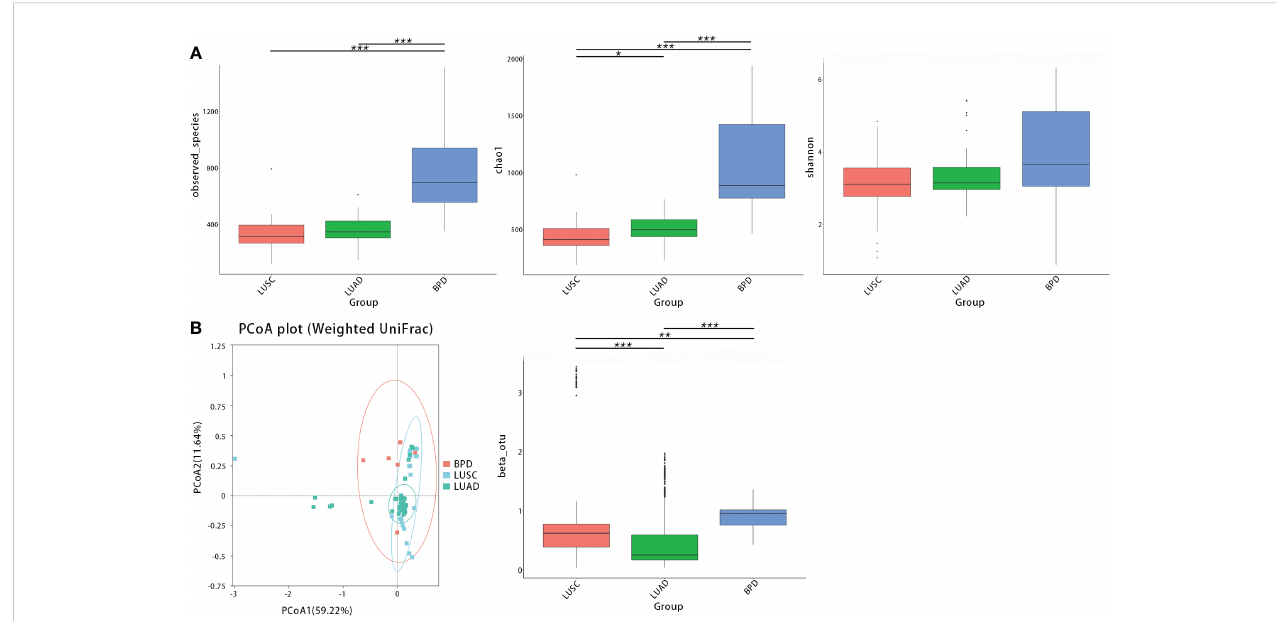
FIGURE 2 The taxonomic diversity of respiratory microbiota by group (LUSC vs . LUAD vs . BPD). (A) Signi fi cant differences in observed OTUs and Chao1 were observed between each group. No signi fi cant difference was observed between each group regarding Shannon ’ s index. (B) Principal coordinate analysis (genus level) using the weighted UniFrac distance displayed the dissimilarities of respiratory microbiota between each group. (* p < 0.05, ** p < 0.01, and *** p < 0.001, similarly